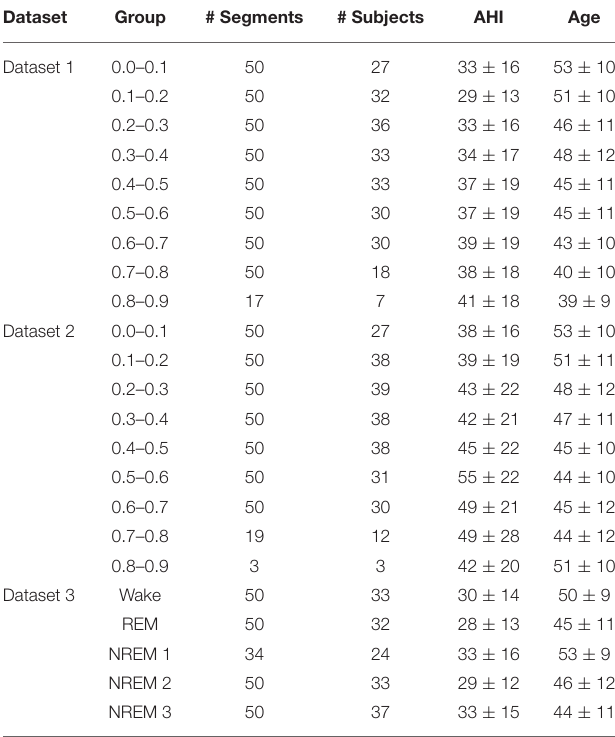
TABLE 2 | Distribution of the segments per